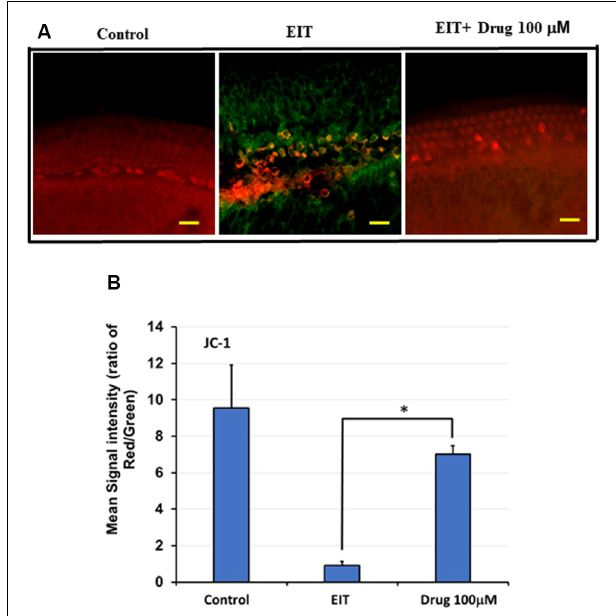
FIGURE 6 | TDCA prevents EIT induced loss of mitochondrial membrane potential (MMP). (A) OC explants were stained with JC-1 probe to determine MMP. EIT exposed OCs showed red and green staining indicating loss of MMP whereas explants in control and TDCA treated group showed only red staining suggesting preservation of MMP. (B) The mean red/green staining signal intensity ratio was calculated using ImageJ software. Data are expressed as mean values ± SD and are representative of three independent experiments. ∗ P < 0.001 compared to the EIT group. n = 6 OCs per group. Scale bars: 10 µ